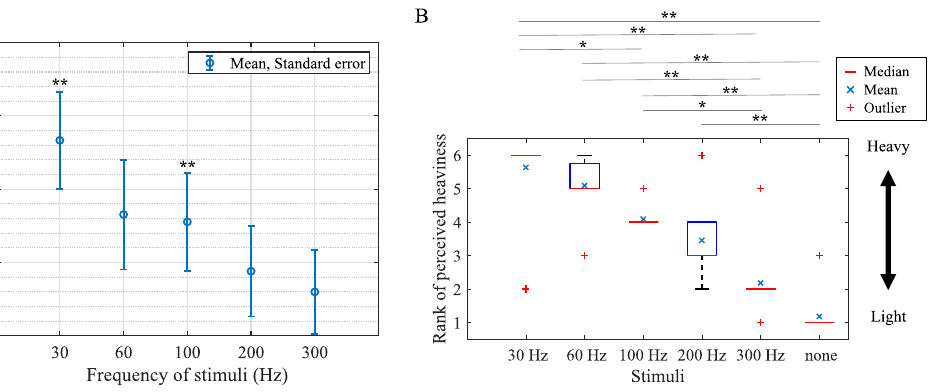
Figure 3. Results of Experiment 1. Stimuli with five different frequencies were used and their amplitudes were 3 dB higher than the thresholds for the weight illusion at each frequency. ( A ) Increase in grip force for five vibratory frequencies. ( B ) Ranks of perceived heaviness. A higher rank number indicates a perception of greater heaviness. * and ** indicate significant differences at the 5% and 1% levels, respectively. There was a positive correlation between the increase in grip force and perceived heaviness ( ρ = 0.66, p = 1.24 × 10 − 9 ).